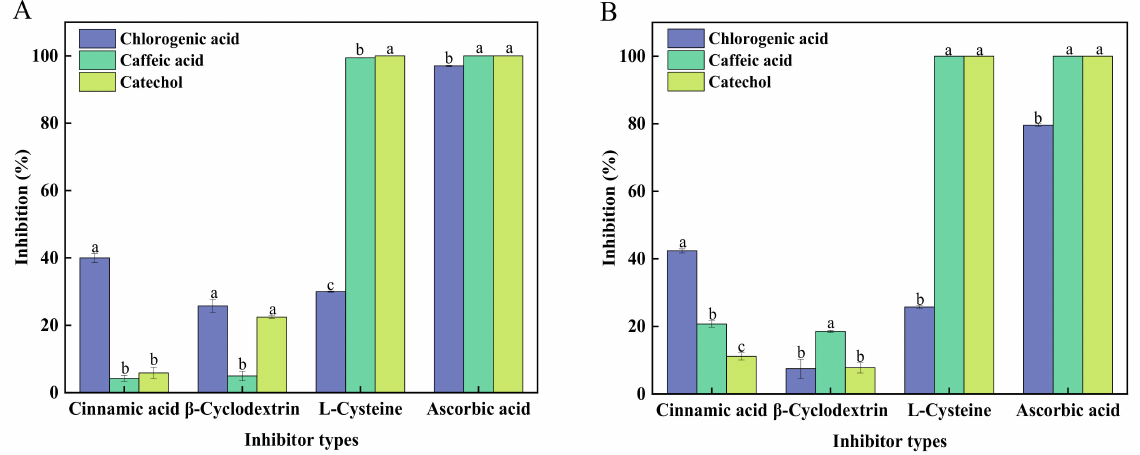
Figure 2. The effect of inhibitors on sPPO- ( A ) and mPPO- ( B ) catalyzed reactions with different substrates, including CA (final concentration of 3 mM), caffeic acid, and catechol (final concentration of 10 mM). The concentration of inhibitors studied in this experiment was 3 mM. Different letters indicate significantly different inhibitory effects when using different substrates ( p <